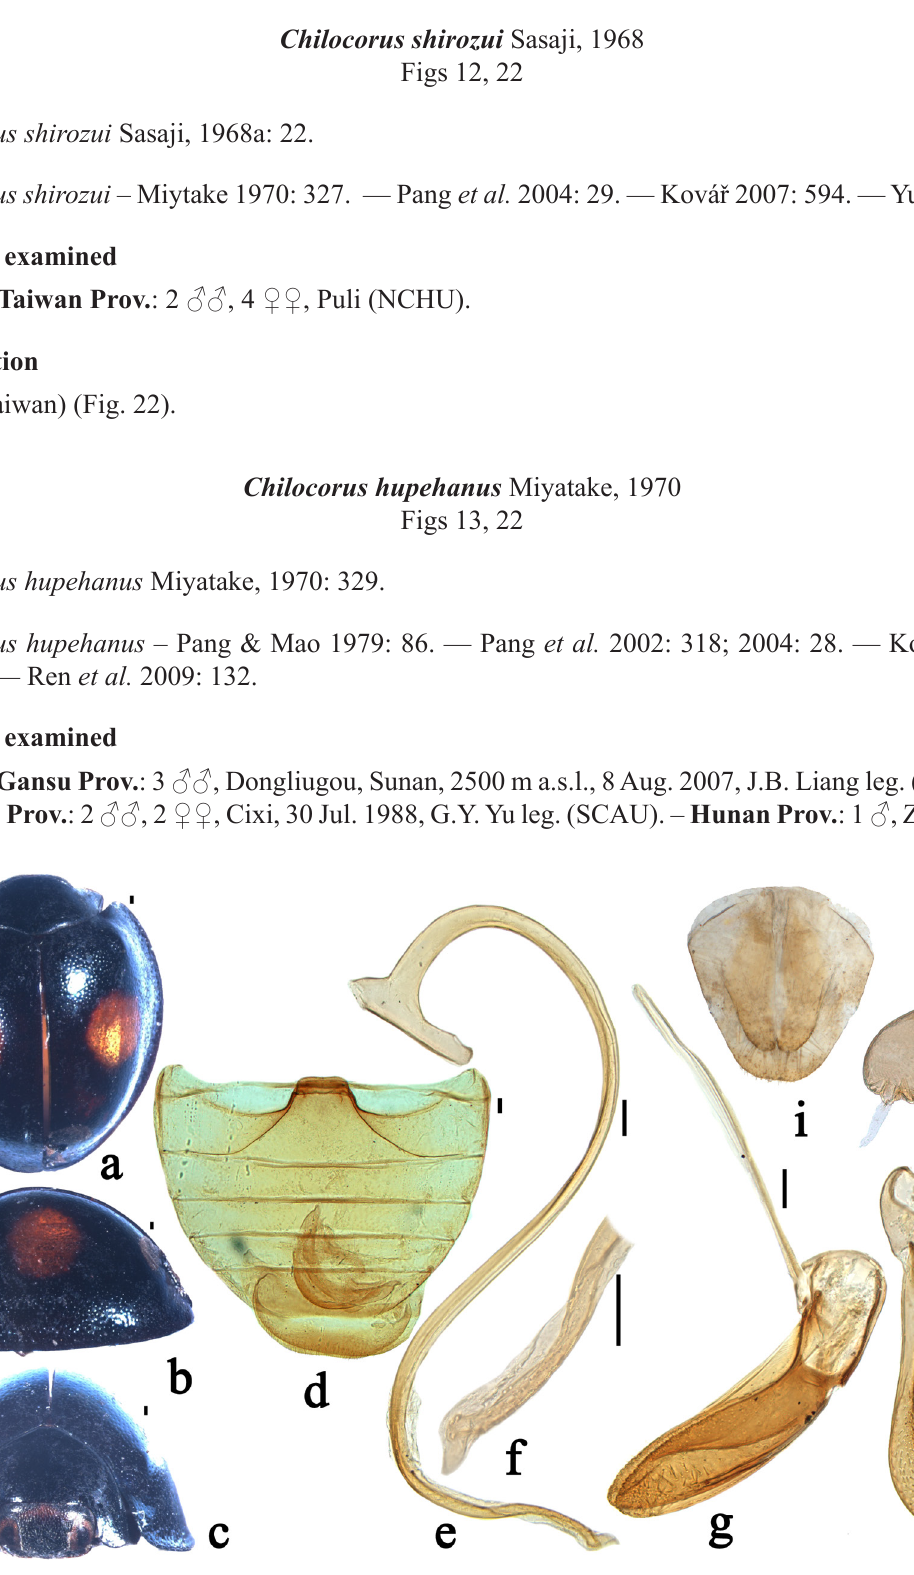
Fig. 12. Chilocorus shirozui Sasaji, 1968. a . Dorsal view. b . Lateral view. c . Frontal view. d . Abdomen. e . Penis. f . Apex of penis. g . Tegmen, lateral view. h . Tegmen, ventral view. i–j . Female genitalia. i . Ovipositor. j . Spermatheca. Scale bars: 0.1